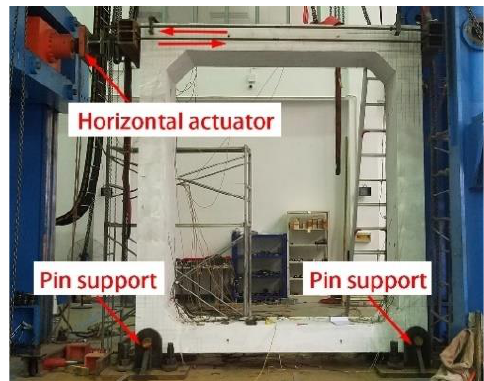
Materials 2022 , 15 , x FOR PEER REVIEW